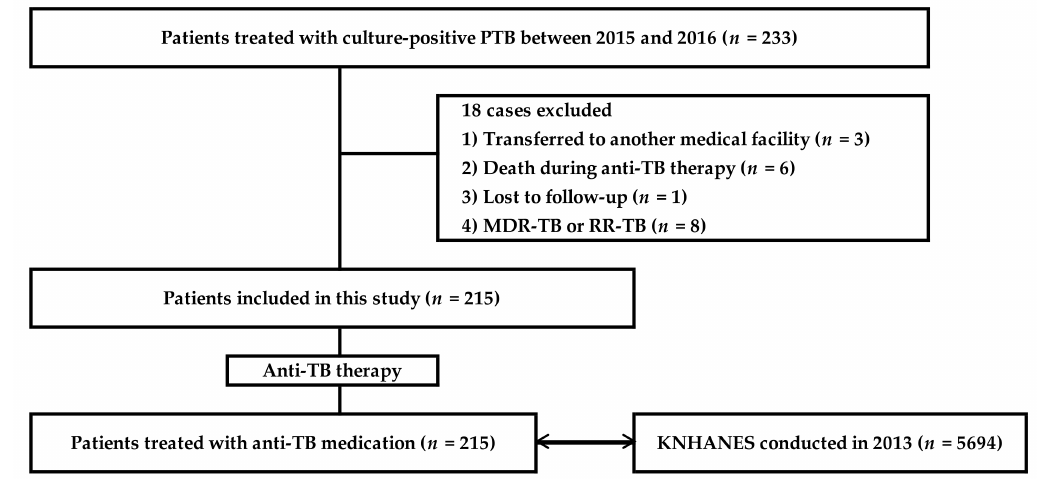
Figure 1. Flow chart of the study. PTB, pulmonary tuberculosis; MDR, multi-drug resistant; TB, tuberculosis; RR, rifampicin resistance; KNHANES, Korea National Health and Nutrition Examination